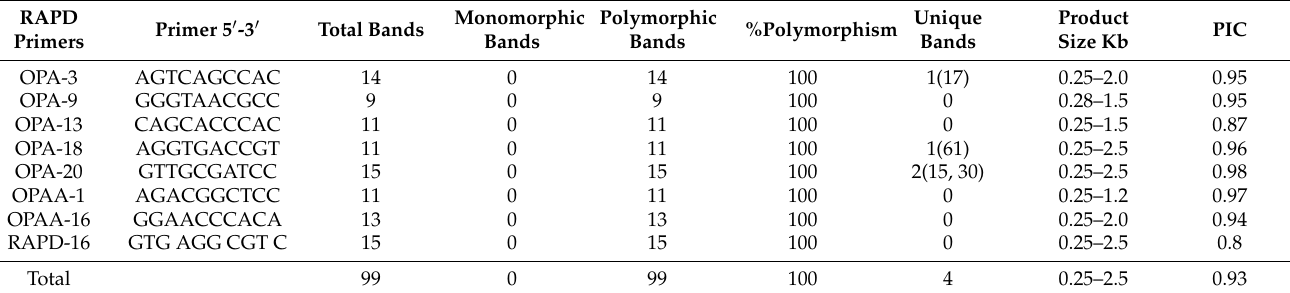
Figure 3. Variability in Karnal bunt coefficient of infection ( A ) and percent infection ( B ) for T. indica isolates sampled from different districts of diverse wheat growing regions of Pakistan. Table 5. Characteristics of different RAPD primers in T. indica